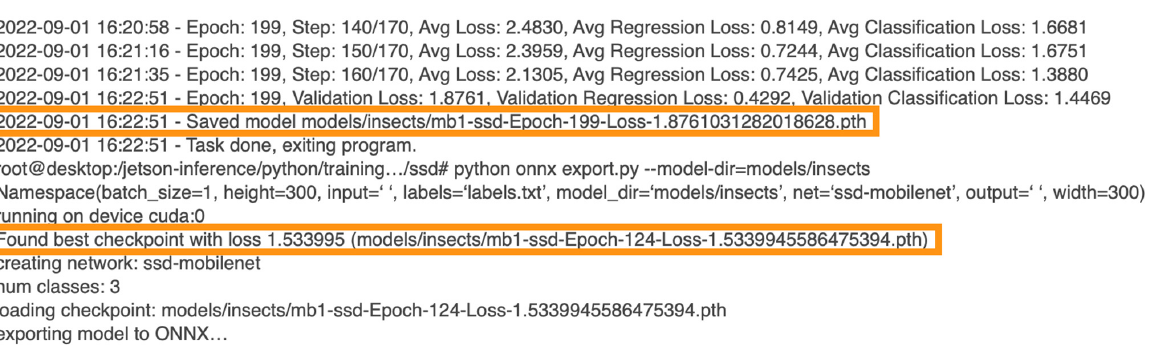
Figure 9. The actual live camera shot detected and identified the beetle side-by-side.